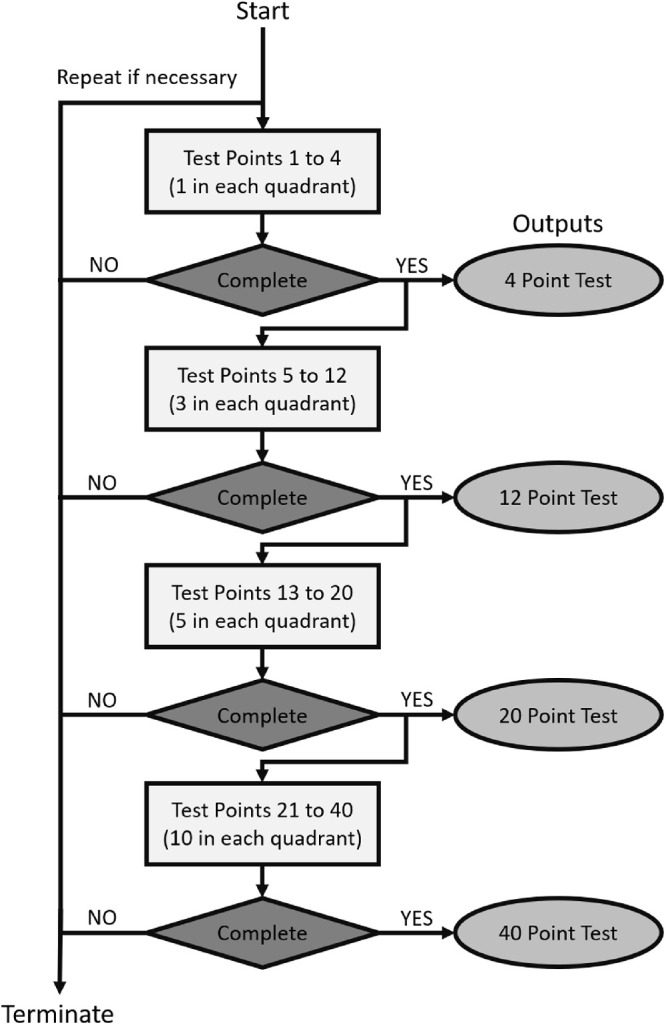
Flow diagram describing the tiered approach for testing infants, starting from a basic 4-point test (1 point in each quadrant) and progressively introducing points to a complete 40-point test pattern.